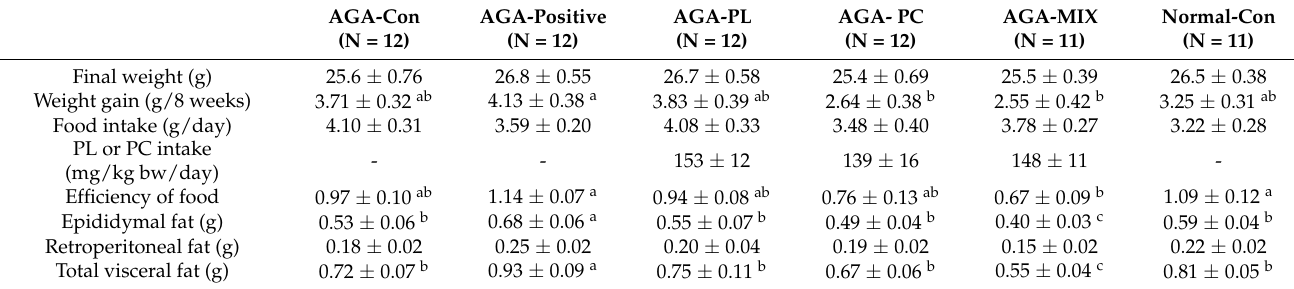
Table 1. Body composition and food intake at the end of the experimental